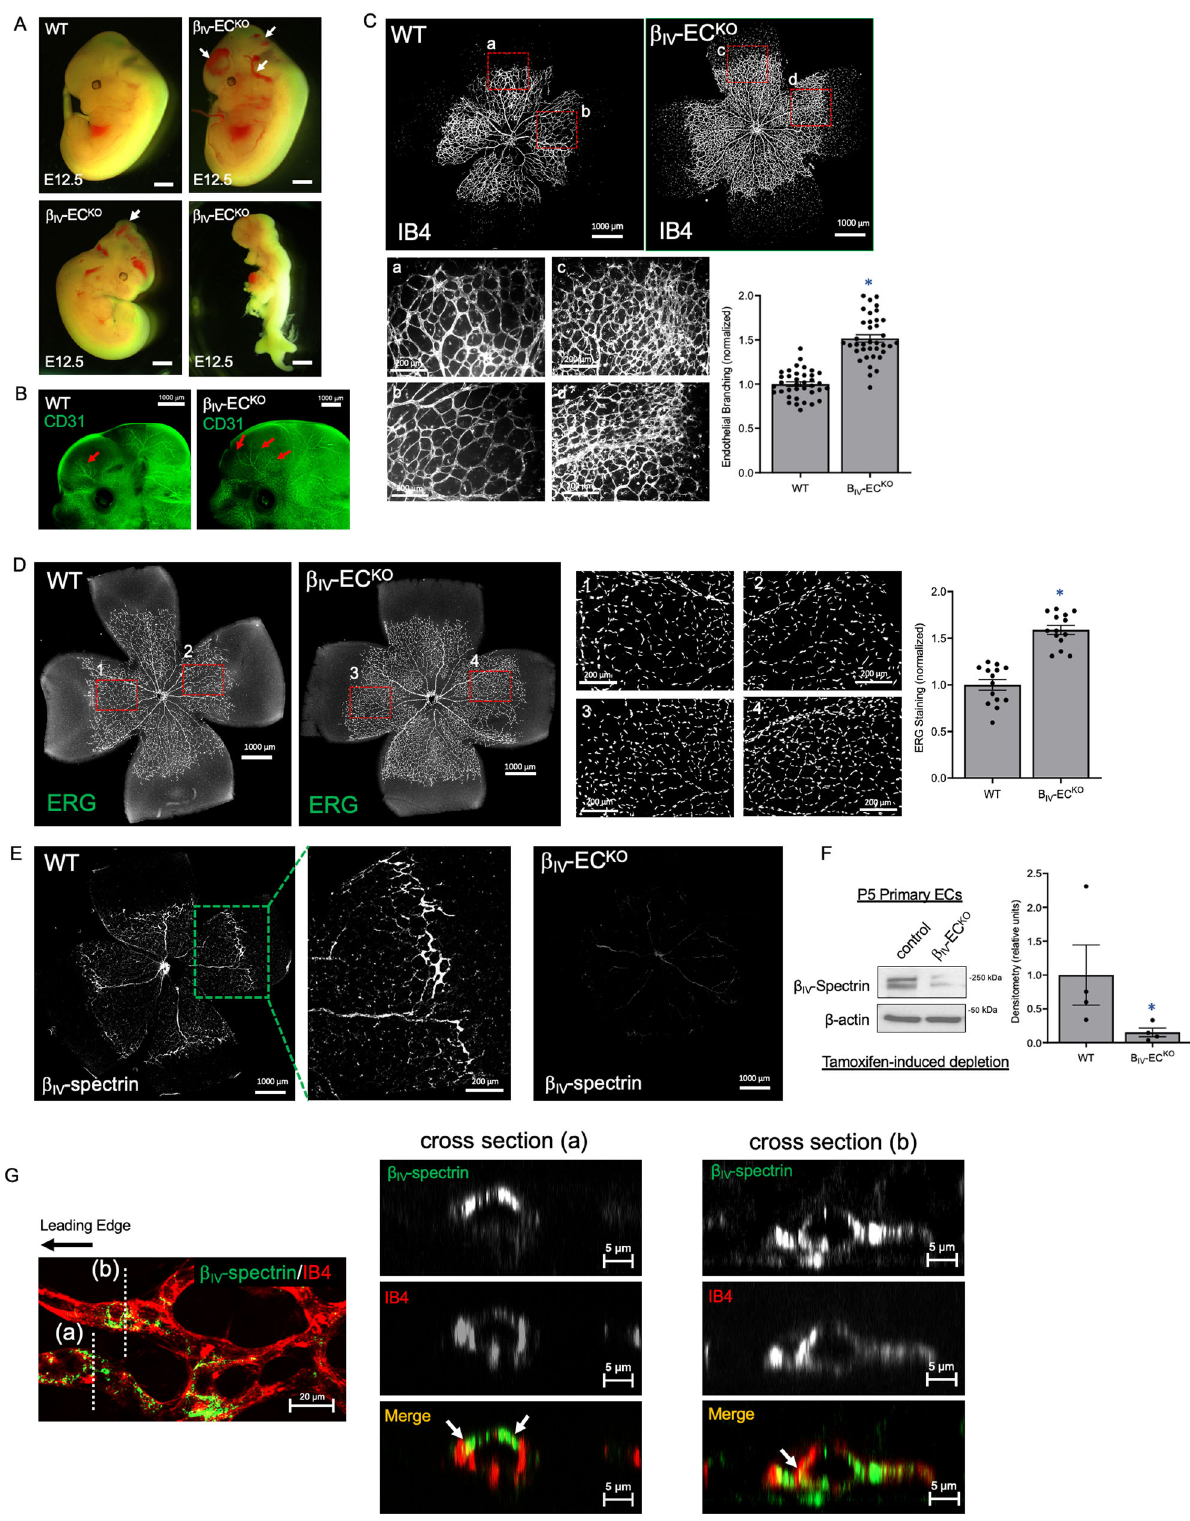
β IV -spectrin/CaMKII complex promotes VEGFR2 degradation . To understand how β IV -spectrin controls angiogenesis at the cellular level, we began by assessing its subcellular localization. Here, confocal Z-stack analysis of endogenous β IV -spectrin revealed its distinct punctate distribution along the basolateral membrane compartments when compared to